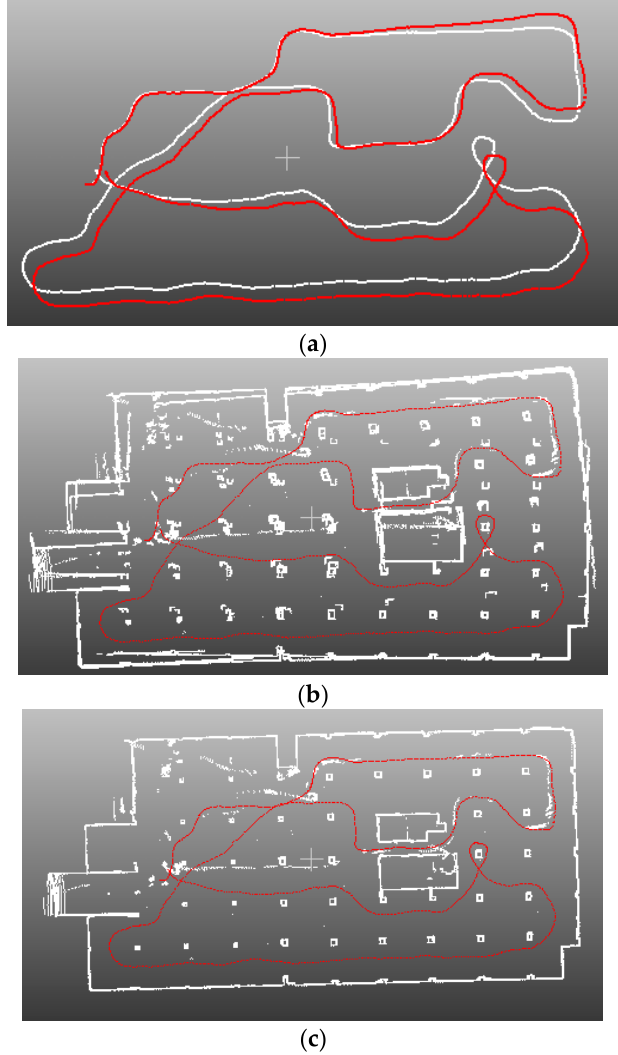
Figure 13. ( a ) trajectory comparison. Red line is the trajectory of our method before Gmapping refinement; white line is the result after refinement; ( b ) 2D map built by trajectory without refinement; ( c ) 2D map built by trajectory with Gmapping refinement. Sensors 2016 , 16 , 1265